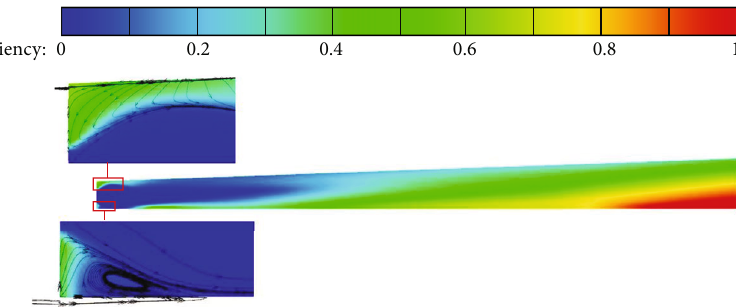
Figure 17: The mixing e ffi ciency at the plane of y = 0